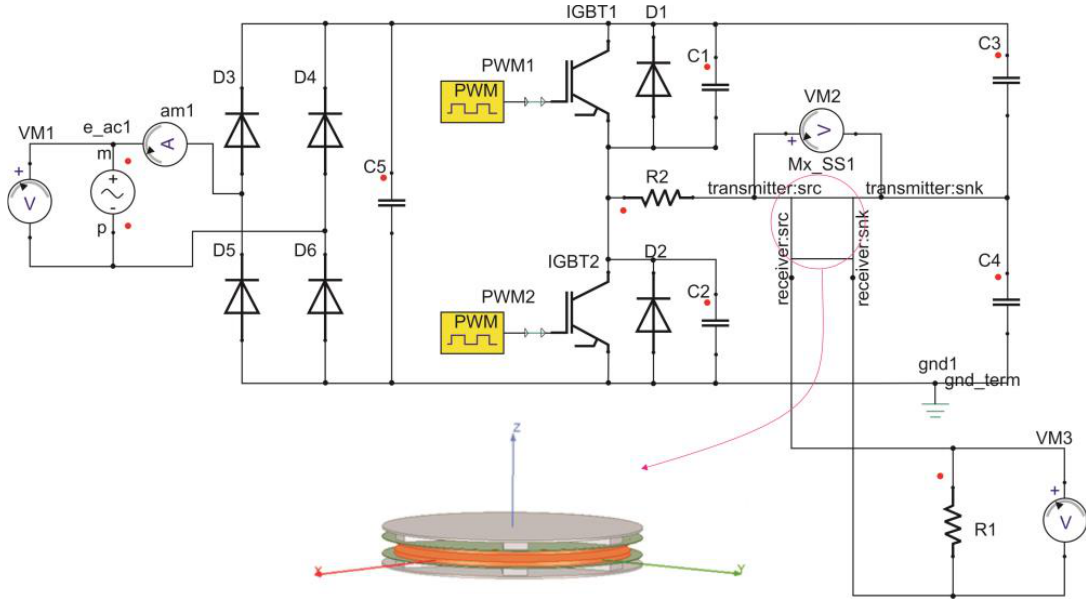
Energies 2023 , 16 , x FOR PEER REVIEW Figure 11. WPT circuit Simplorer simulation model. Figure 11. WPT circuit Simplorer simulation model.